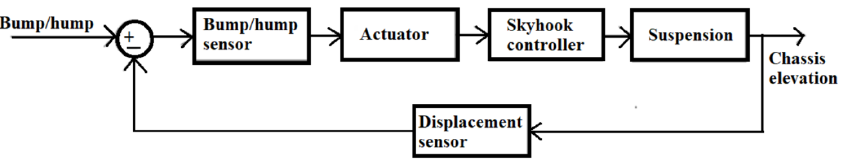
Figure 7. Real closed-loop